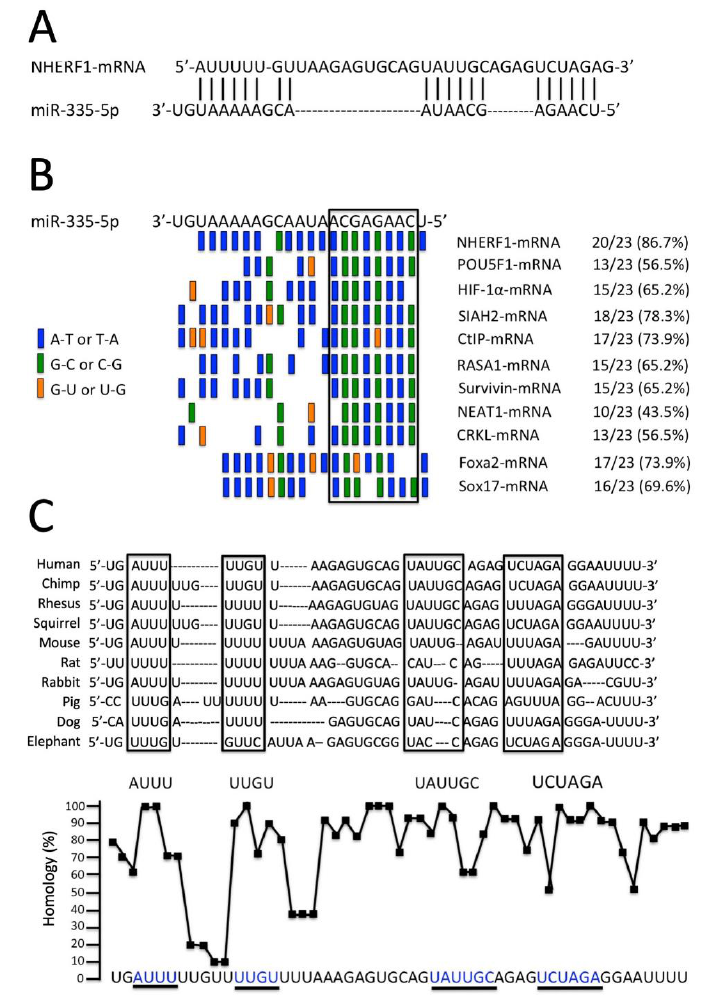
Figure 2. ( A ) Predicted interaction between miR-335-5p and 3′-UTR of NHERF1 mRNA. ( B ) Comparison of NHERF1 binding to miR-335-5p to that of other validated miR-335-5p regulated mRNAs. This is, to our knowledge, the highest value described in the literature. In fact, lower values were found (Figure 2B) when the analysis was conducted on the interactions between miR- 335-5p sequence and validated miR-335-5p regulated mRNAs. POU5F1: POU Class 5 Homeobox 1 [50]; HIF-1α: Hypoxia-inducible factor 1-alpha [51]; SIAH2: Siah E3 Ubiquitin Protein Ligase 2 [52]; CtIP: CTBP-Interacting Protein [53]; RASA1: RAS P21 Protein Activator 1 [54]; survivin [55]; NEAT1: Nuclear Paraspeckle Assembly Transcript 1 [56]; CRKL: CRK Like Proto-Oncogene, Adaptor Protein [57]; Foxa2: Forkhead Box A2 [58] and Sox17: SRY-Box 17 [58]. ( C ) The binding sites for miR-335-5p are conserved throughout molecular evolution of the NHERF1 gene. Upper part of the panel: alignment of the miR-335-5p binding sites within the 3 (cid:48) -UTR region of NHERF1 gene of Homo sapiens (Human), Pan troglodytes (Chimp), Macaca Mulatta (Rhesus), Saimiri sciureus (Squirrel), Mus musculus (Mouse), Rattus norvegicus (Rat), Oryctolagus cuniculus (Rabbit), Sus scrofa (Pig), Bos taurus (Cow), Felis catus (Cat), Canis lupus familiaris (Dog), Myotis lucifugus (Brown bat) and Loxodonta africana (Elephant). Lower part of the panel: level of homology shown for each nucleotide. The sequences complementary to miR-335-5p (see panel A) are boxed and underlined in the upper and lower part of the panel,